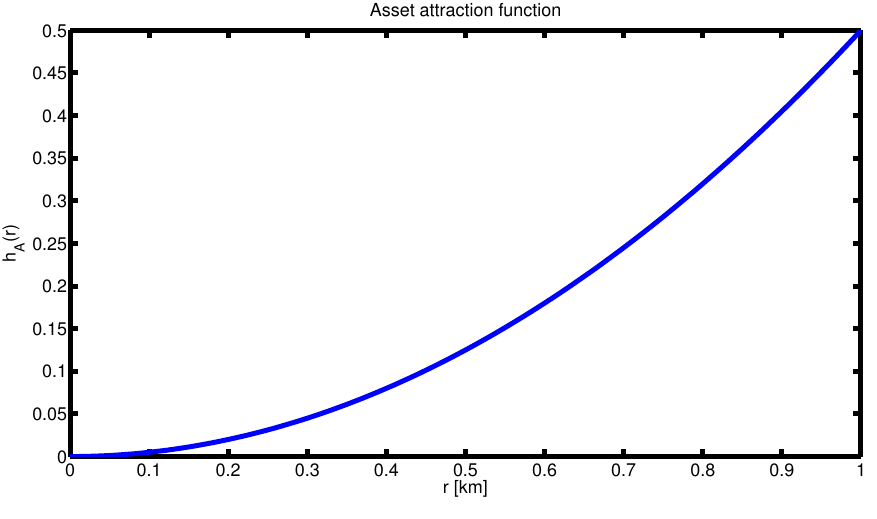
Figure 4. Function of interest for task 1: move towards the asset to be protected. The higher the distance from the asset the higher the interest in fulfilling the